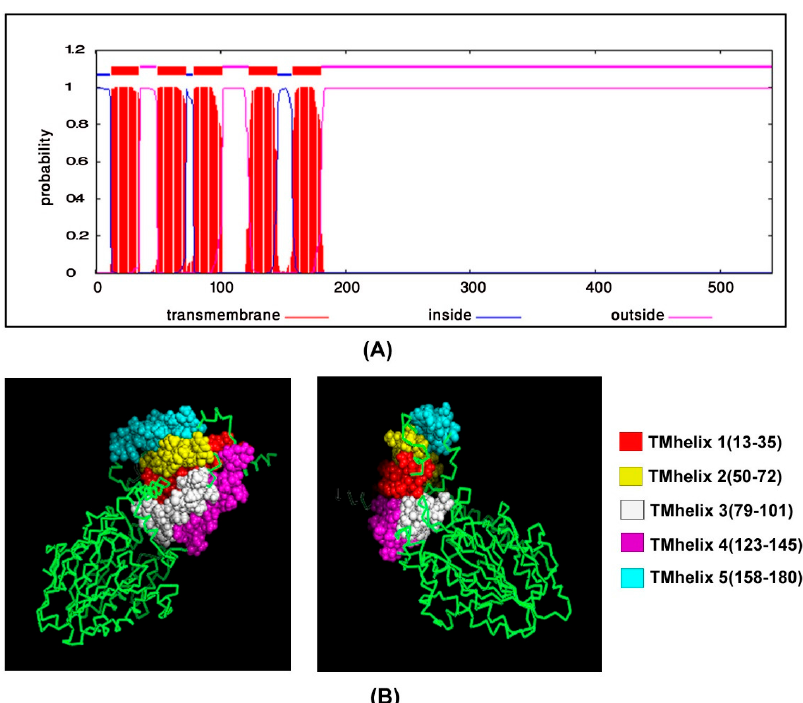
Figure 4. Transmembrane topology prediction of Salmonella SAUVM S6 MCR-1 protein. TMHMM server v.2.0 (http://www.cbs.dtu.dk/services/TMHMM/) was used to predict the ( A ) transmembrane helices of MCR-1 proteins and the image showed TMHMM posterior probabilities of SAUVM S6. ( B ) The topology was shown as the position of the transmembrane helices differentiated by “i” and “o” when the loop is on the inside and outside, respectively.